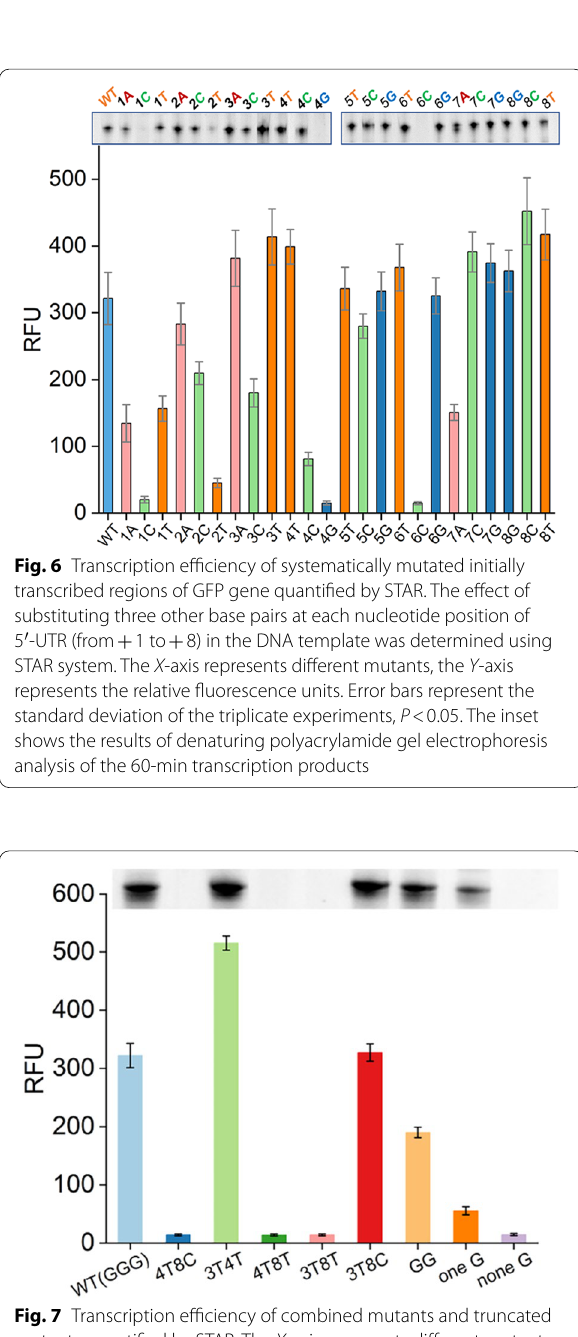
showing that T7 RNAP depends on G at position initiate transcription reactions and with common guide- lines for T7 RNAP usage in RNA biology (Passalacqua et al. 2020).